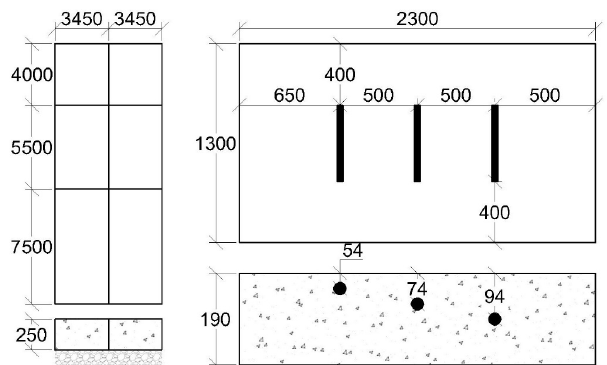
Figure 2. TS’ (left) and CS’ (right) designs (Units: mm.)